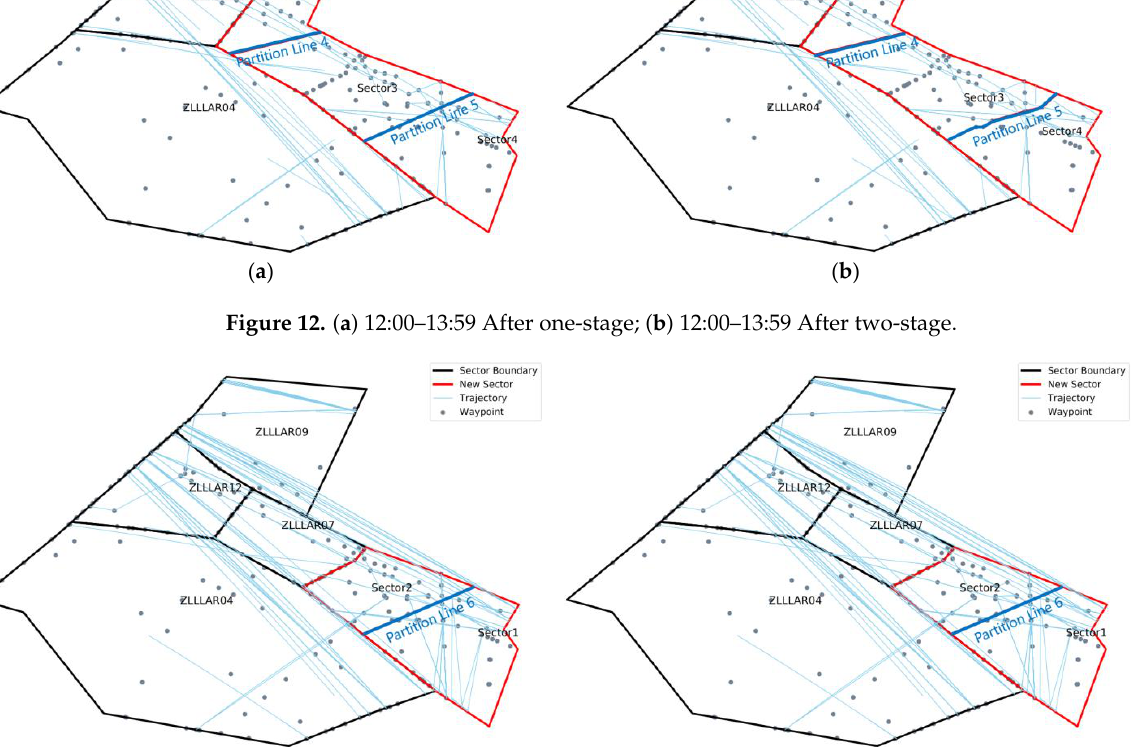
Table 8. 12:00 – 13:59 Workload values for each sector before and after optimization. Before